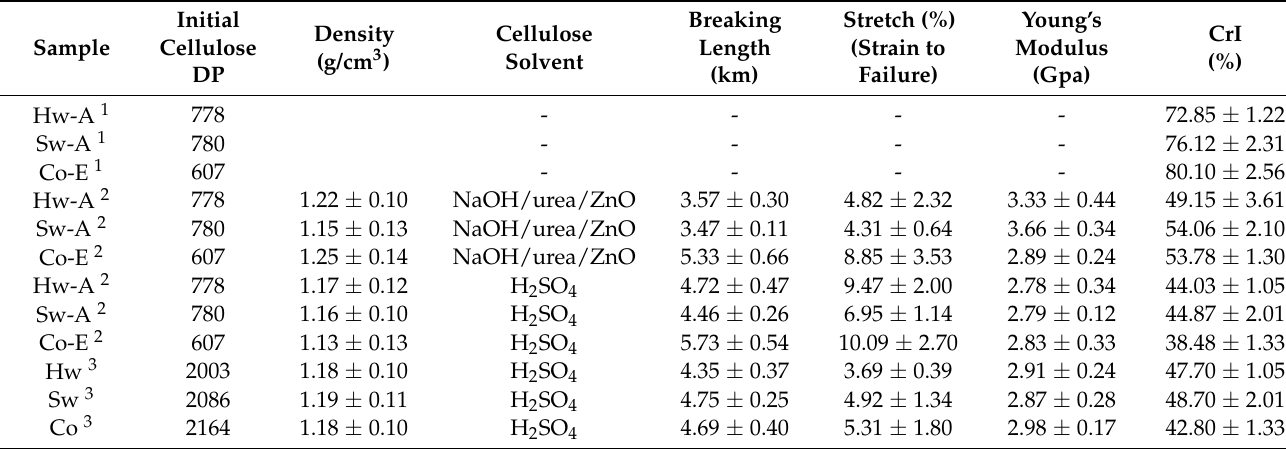
Table 4. Physical properties of films prepared from low DP cellulose by using NaOH/urea/ZnO and sulfuric acid as cellulose